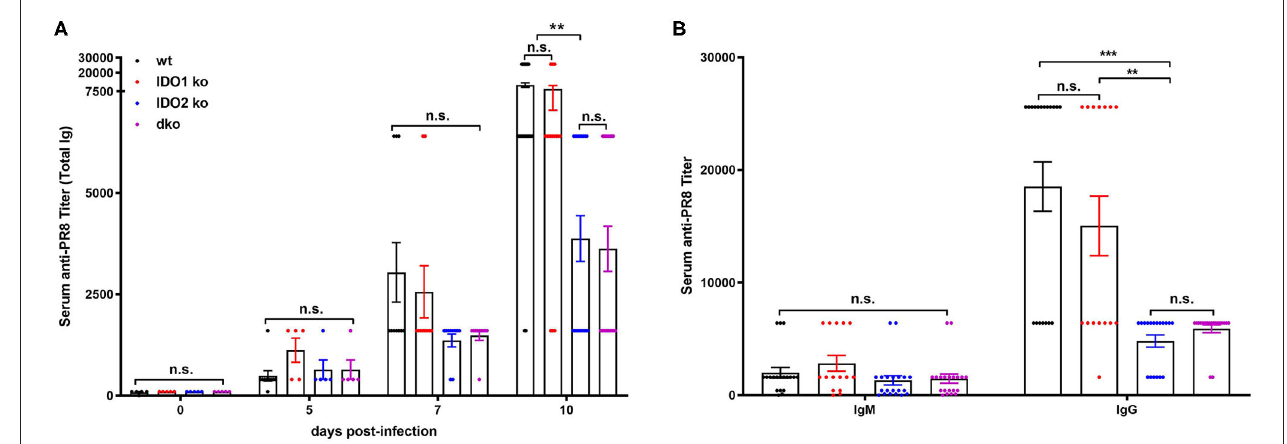
FIGURE 7 | IDO2 deficient mice generate reduced antibody response to influenza. Wt, IDO1 ko, IDO2 ko, and dko C57BL/6 mice were infected with 200 TCID 50 influenza virus (A/PR/8/34). (A) Titers of anti-PR8 Ig were measured on days 0, 5, 7, and 10 by ELISA. Symbols represent individual mice and histograms show mean serum anti-PR8 Total Ig titer ± SEM for a minimum of n = 10 mice per group. (B) Symbols represent individual mice and histograms show mean serum anti-PR8 IgM vs. IgG titers ± SEM on day 10 from n = 20 wt, n = 15 IDO1 ko, n = 20 IDO2 ko, and n = 20 dko B6 mice. Data are pooled from 4 independent experiments. P -values were calculated by one way-ANOVA followed by comparison of means with Tukey’s post-hoc multiple comparison correction. ** p < 0.01, *** p < 0.0001, n.s., not